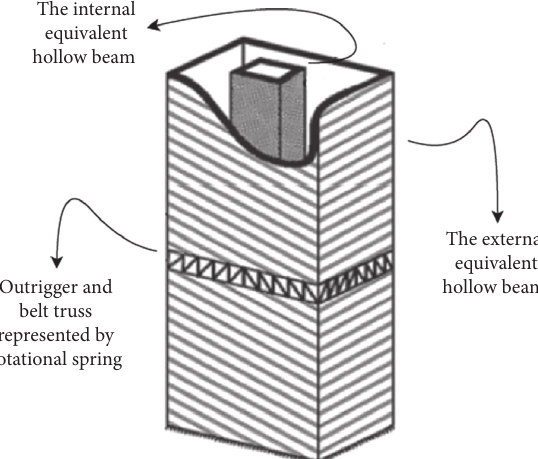
Figure 4: The equivalent model of combined system of multiple tubes, core, and outrigger and belt truss